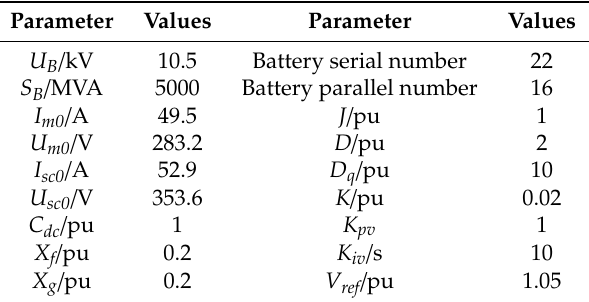
Table 1. Main parameters.